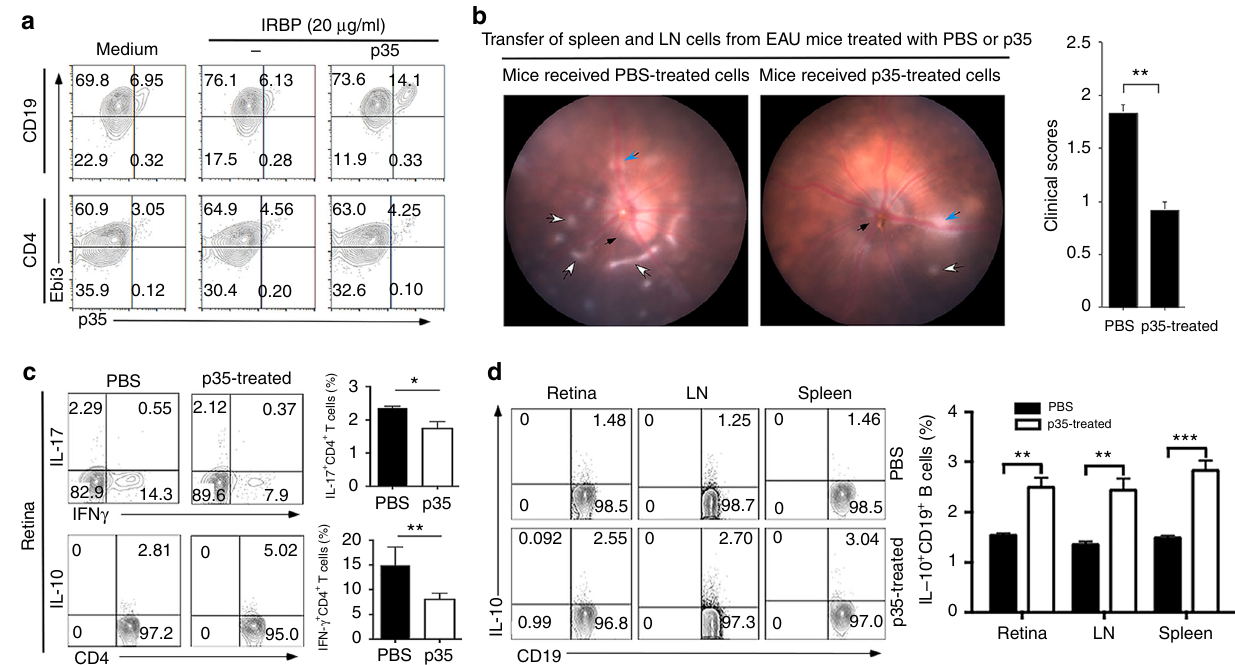
Fig. 6 Uveitogenic T cells exposed to p35 in vivo loss capacity to transfer EAU. a Cells from the draining LN and spleens of EAU mice were re-stimulated ex vivo with IRBP in presence or absence of p35 and analyzed by intracellular cytokine assay. Numbers in the quadrants indicate the percentages of B or T cells expressing IL-35 (p35 and Ebi3). b EAU was induced in C57BL/6J mice by active immunization with IRBP and some of the mice were treated with p35 or PBS. Draining LN and spleen cells isolated 21 days post-immunization were re-stimulated ex vivo with IRBP and transferred (1×10 7 cells) into naive syngeneic mice. Ten days after adoptive transfer the eyes were examined by funduscopy. Images reveal in fl ammation with blurred optic disc margins and enlarged juxtapapillary area ( black arrows ); retinal vasculitis with moderate cuf fi ng ( blue arrows ); yellow − whitish retinal folding and in fi ltrates ( white arrows ). c , d Intracellular cytokine analysis of IL-17- or IFN- γ or IL-10-expressing CD4 + T cells in the retina c or IL-10-producing Breg cells in the retina, LN or spleen b on day 10 after adoptive transfer. Plots were gated on CD4 + T cells or CD19 + B cells and numbers in quadrants indicate percent of cells expressing IL-10, IL-17, and/or IFN-